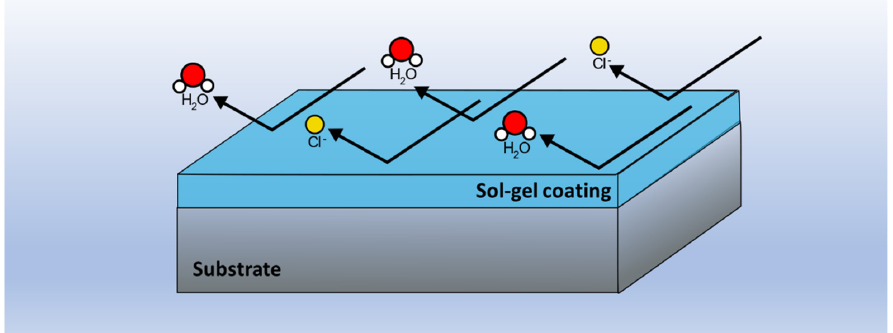
Figure 6. Schematics of a sol-gel coating preventing the corrosion of a metallic substrate by acting as a physical barrier against aggressive elements.